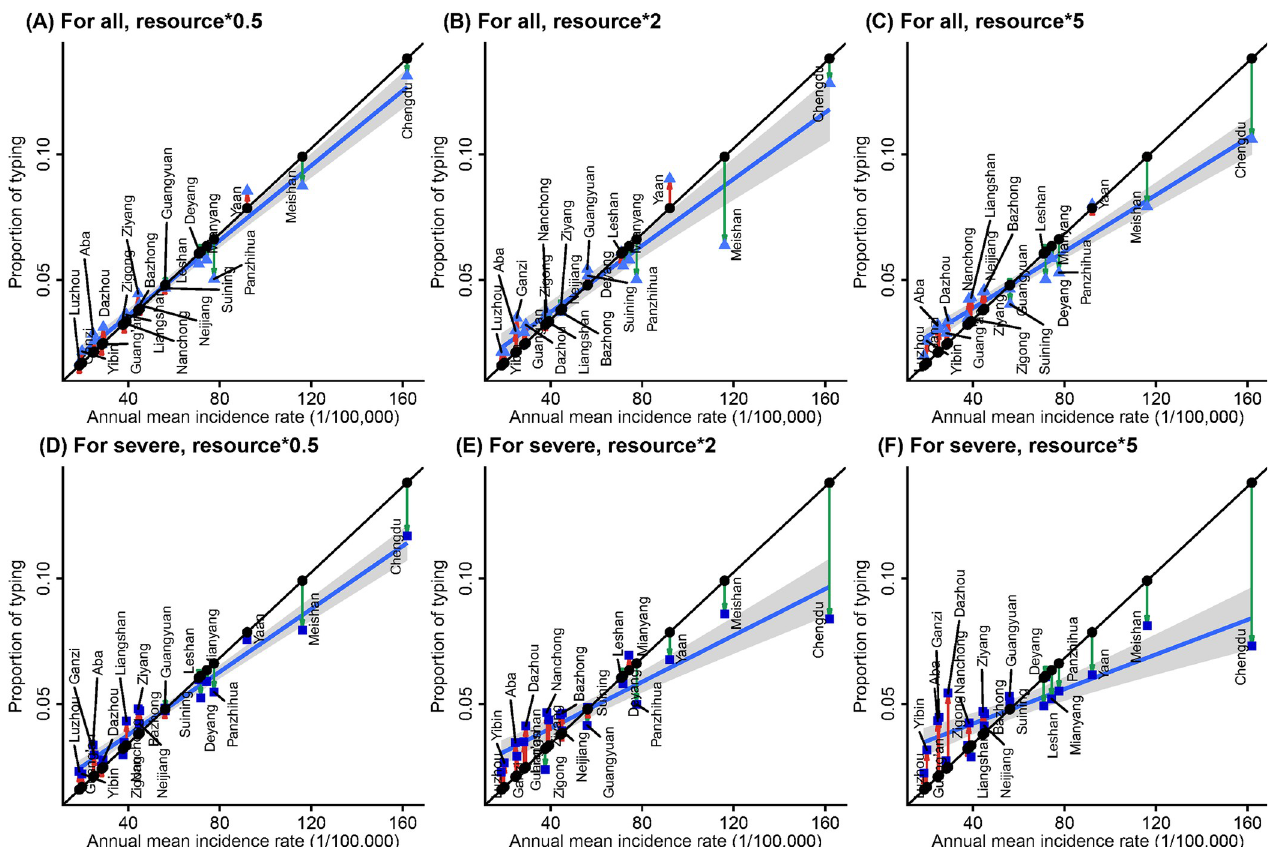
Fig 6. Scatterplots of annual mean incidence rate and the proportion of typing resources allocating to each location under the archetypal design IncRate (black dots) and the Optimal designs for minimizing the MAE of estimated serotype-incidence rate of all HFMD cases (blue triangles) when the available typing resources is (A) halved, (B) doubled, and (C) quintupled; and the Optimal designs for minimizing the MAE of estimated serotype-incidence rate of severe HFMD cases (blue squares) when the available typing resources is (D) halved, (E) doubled, and (F)